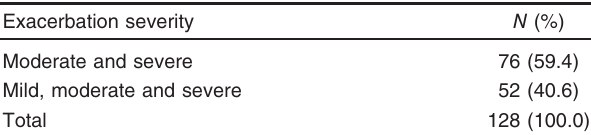
Table 17 Distribution of doctors as regards prescribing antibiotics according to exacerbation severity